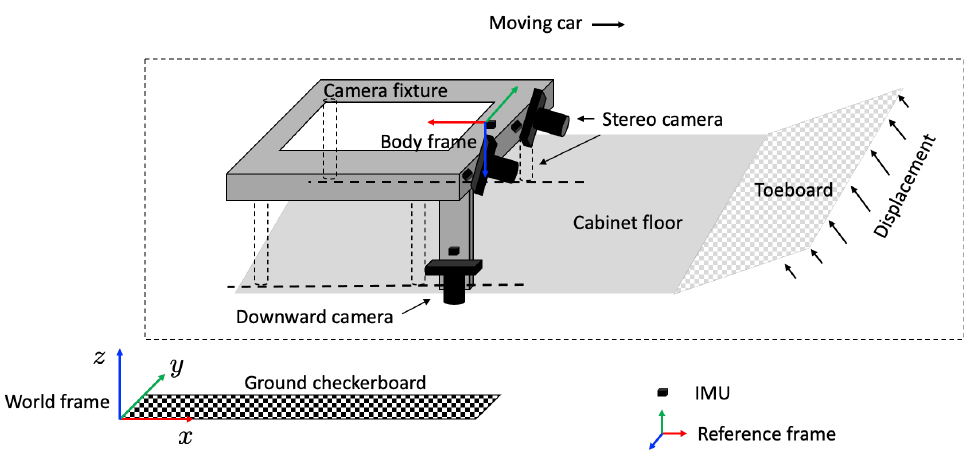
Figure 1. Sensor suite and localization problem